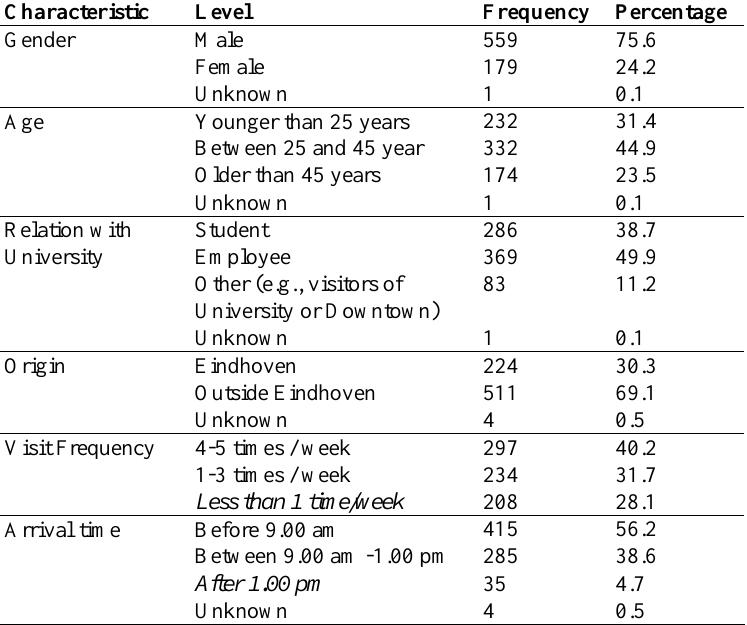
Table 1. Some personal and travel characteristics of the respondents